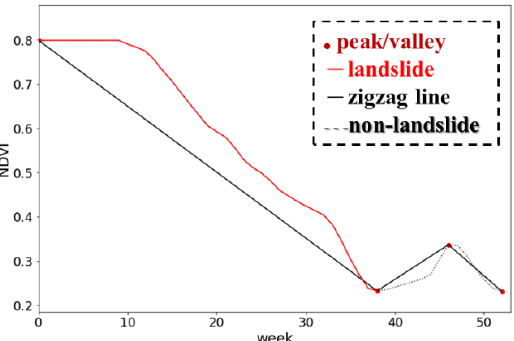
Figure 8. Illustration of landslide interval